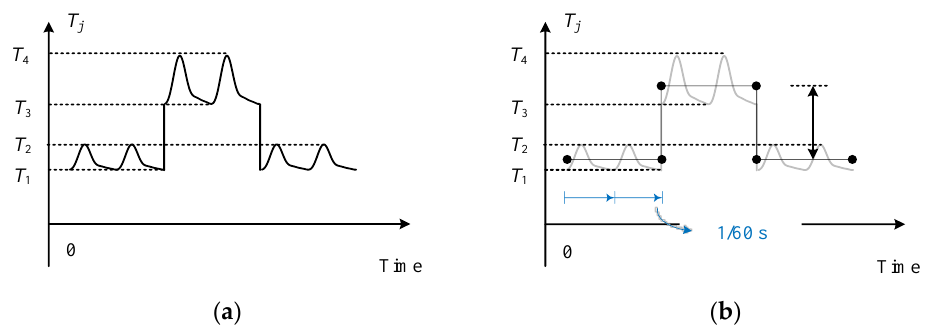
Figure 10. Example of rainflow counting for the semiconductor thermal profile using the average approach. ( a ) Thermal stress history of a semiconductor. ( b ) Peak – valley history of a semiconductor.